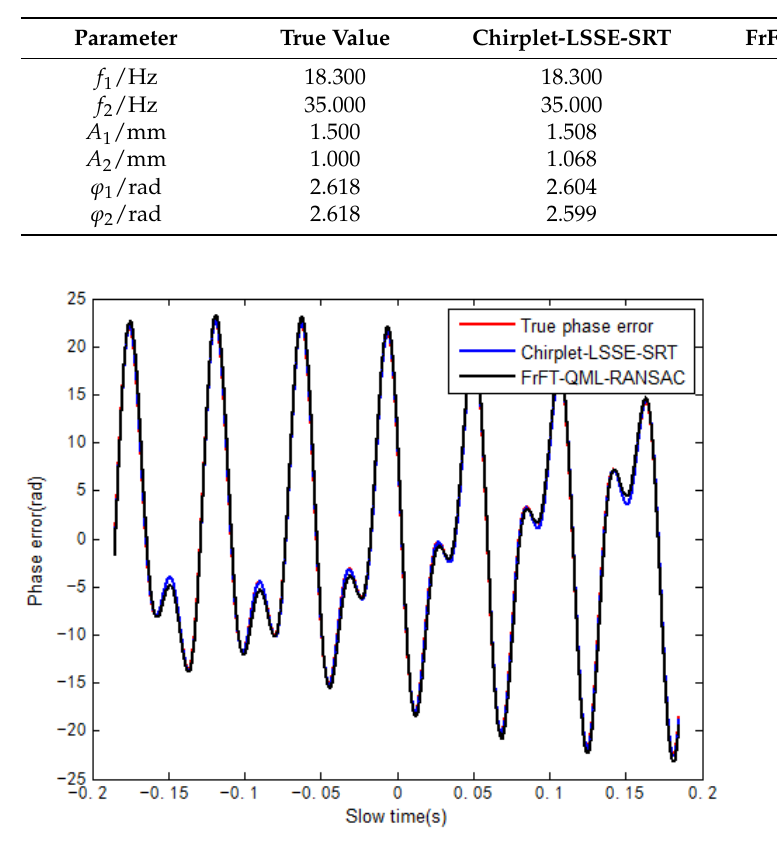
Figure 7. Estimation of phase errors.